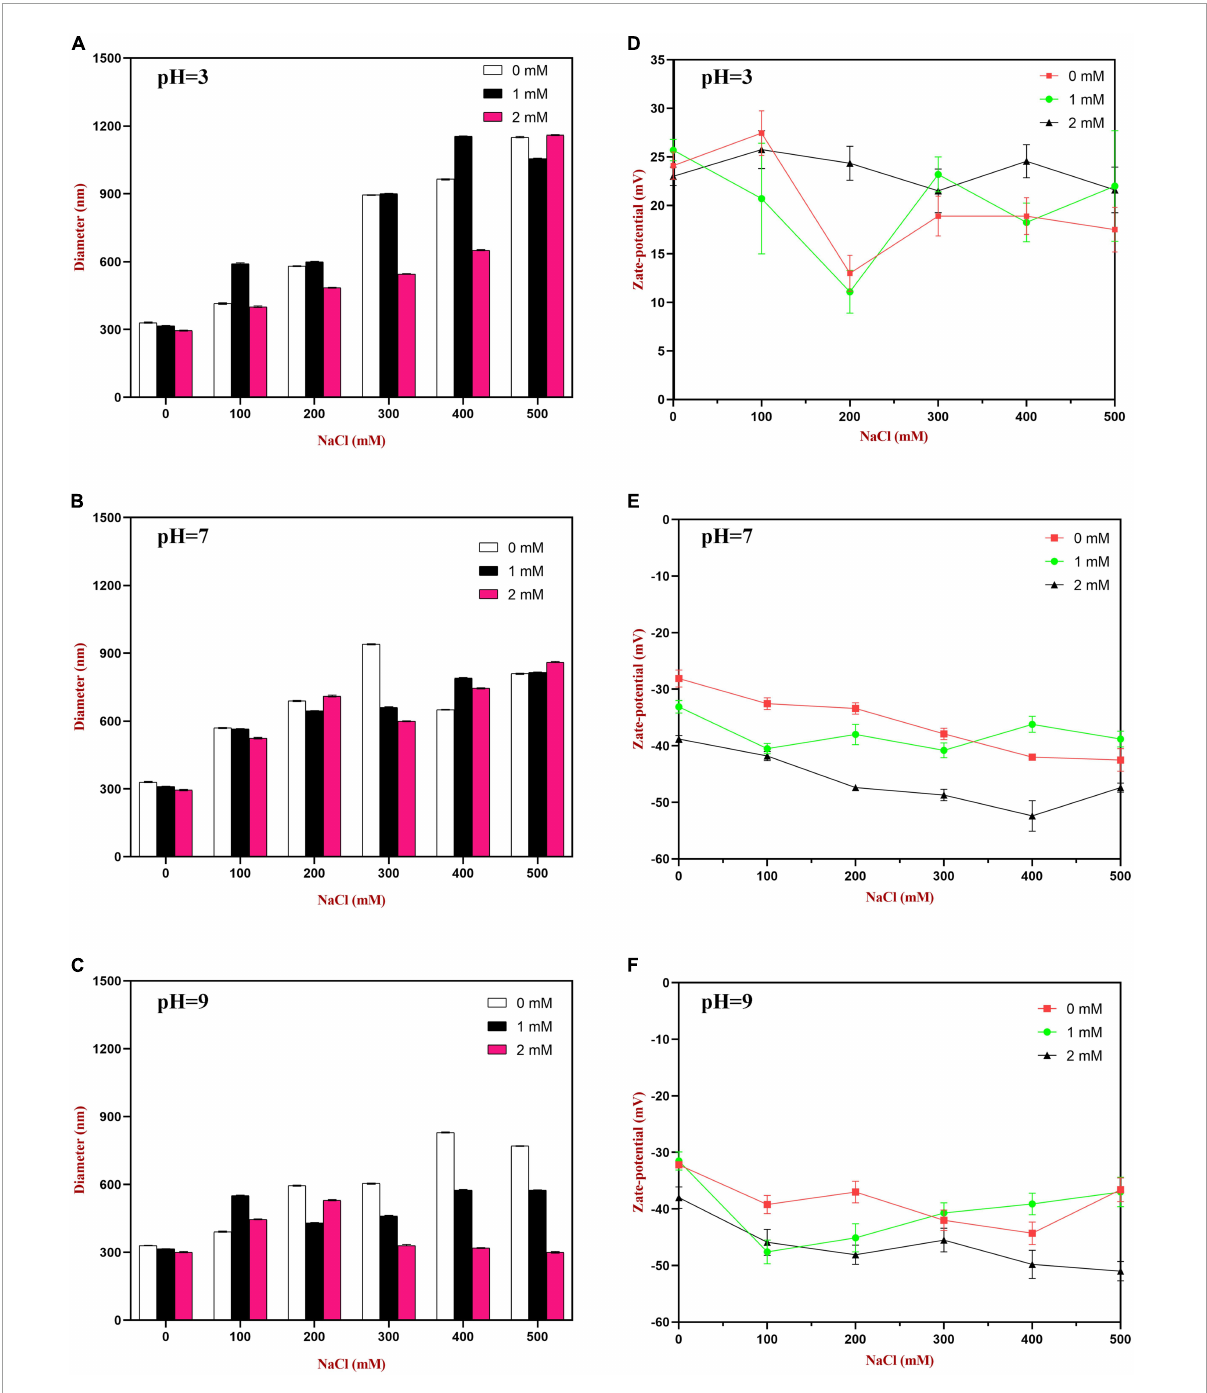
FIGURE9 The particle size (A–C) and zeta-potential (D–F) changes of WP based emulsion or WP-HES based emulsions under different pH values and salt concentrations.